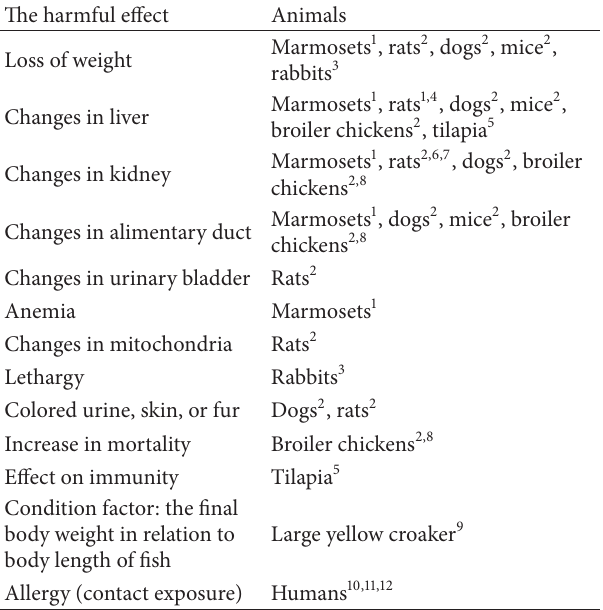
Table4:HarmfuleffectsofEQobservedafteritsoraladministration in different animals or in humans (contact